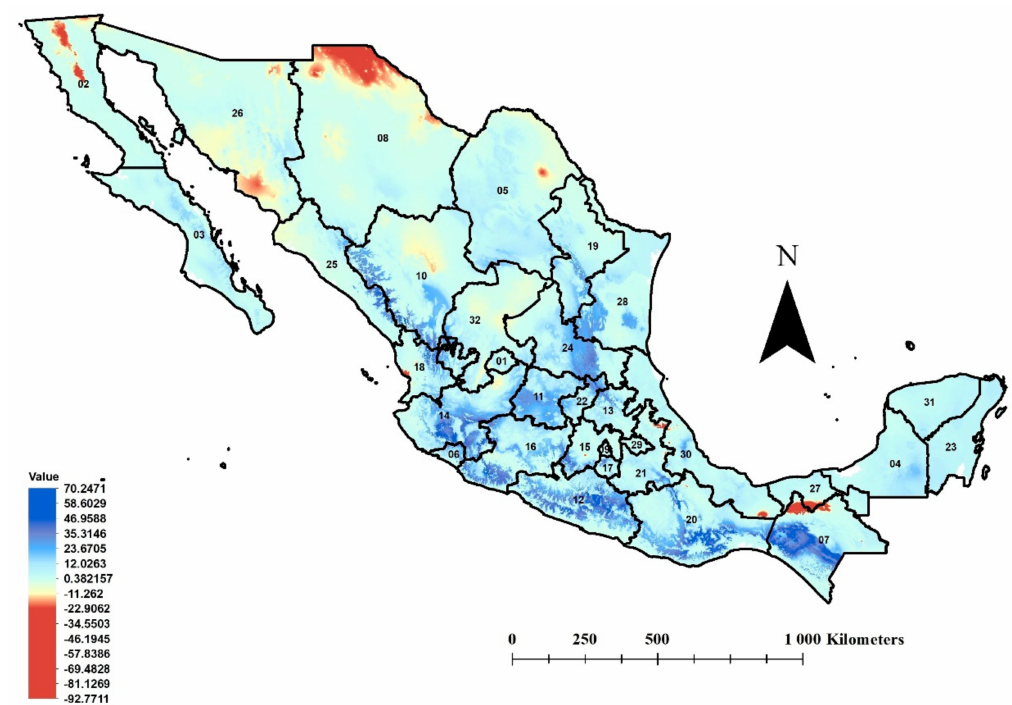
Figure 3. MESS analysis in Mexico for Trioza erytreae . Dark blue color and positive values indicate sites with climatic conditions similar to those in the insect species’ native ecological niche; dark red color and negative values indicate degrees of dissimilarity. State identifications: (1) Aguascalientes, (2) Baja California, (3) Baja California Sur, (4) Campeche, (5) Coahuila, (6) Colima, (7) Chiapas, (8) Chihuahua, (9) Ciudad de Mexico, (10) Durango, (11) Guanajuato, (12) Guerrero, (13) Hidalgo, (14) Jalisco, (15) Estado de Mexico, (16) Michoacan, (17) Morelos, (18) Nayarit, (19) Nuevo Leon, (20) Oaxaca, (21) Puebla, (22) Queretaro, (23) Quintana Roo, (24) San Luis Potosi, (25) Sinaloa, (26) Sonora, (27) Tabasco, (28) Tamaulipas, (29) Tlaxcala, (30) Veracruz, (31) Yucatan, and (32)